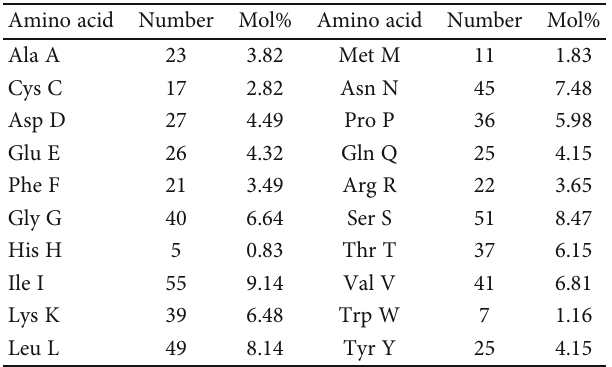
Table 1: Number and Mol% of amino acids that constituted Nipah virus glycoprotein G using BioEdit software version 7.2.5. Amino acid Number Mol% Amino acid Number